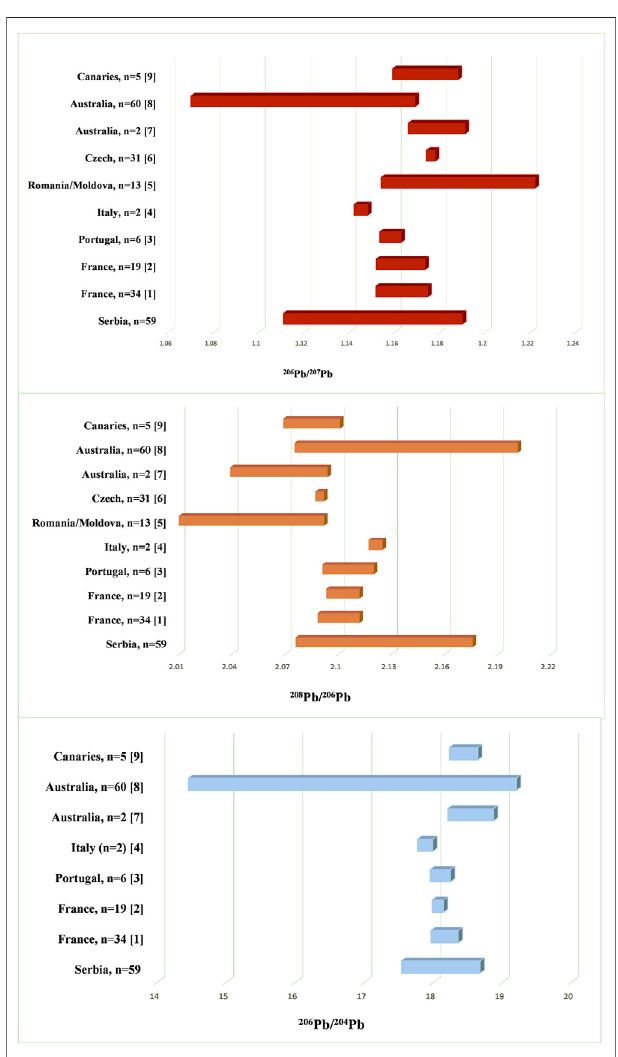
FIGURE 3 | The ranges of the values of 208 Pb/ 206 Pb, 206 Pb/ 207 Pb and 206 Pb/ 204 Pb for wines from differentgeographical areas, reported in